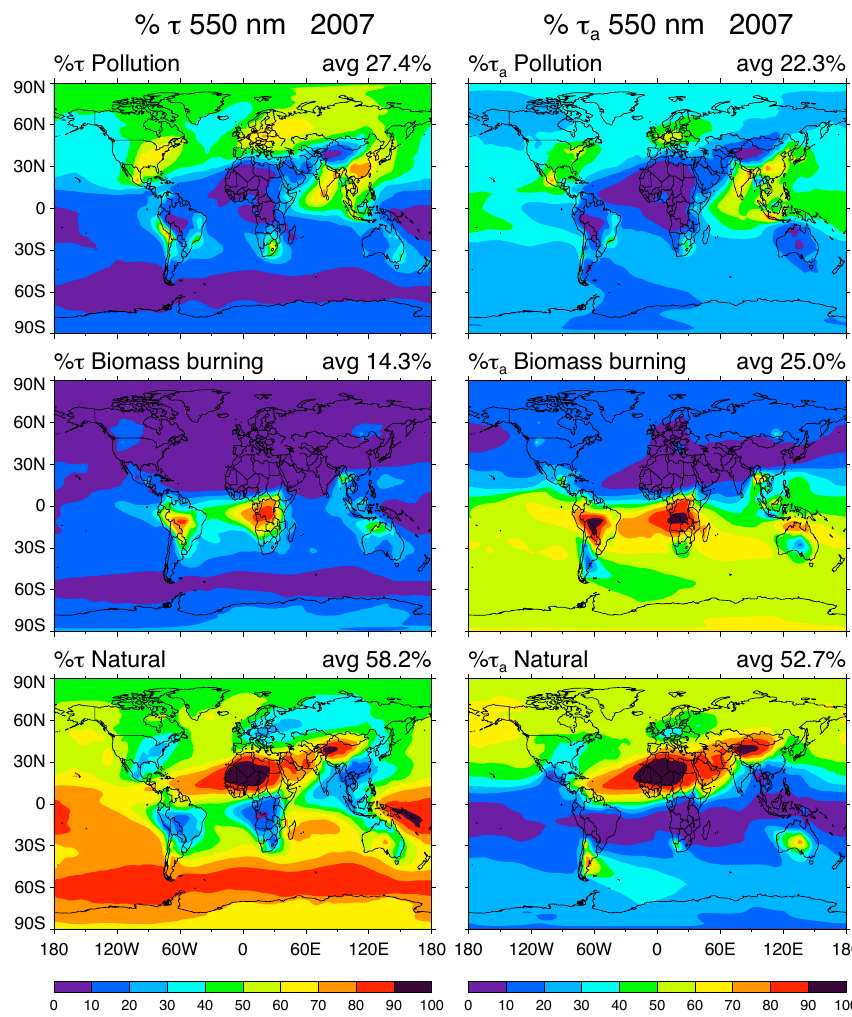
Fig. 10. Percentage contributions to 550nm τ (left column) and τ a (right column) from pollution (top row), biomass burning (middle row), and natural (bottom row) aerosols in 2007. Natural aerosol including dust, sea salt, biogenic, and volcanic aerosols.